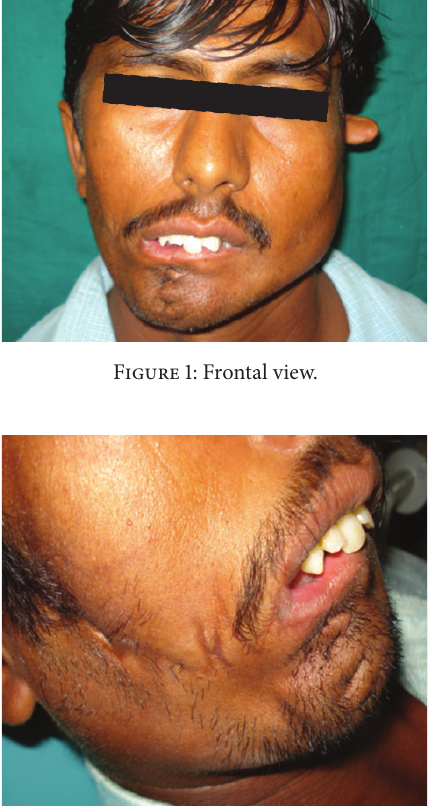
Figure 4: Residual cleft on right soft